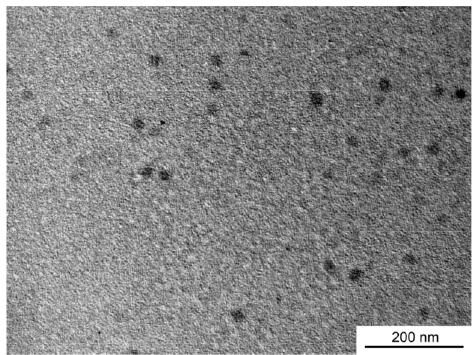
Figure 8. Transmission electron microscopy (TEM) image of the PNaSS 58 – b –PAA 125 /PNaSS 58 – b –